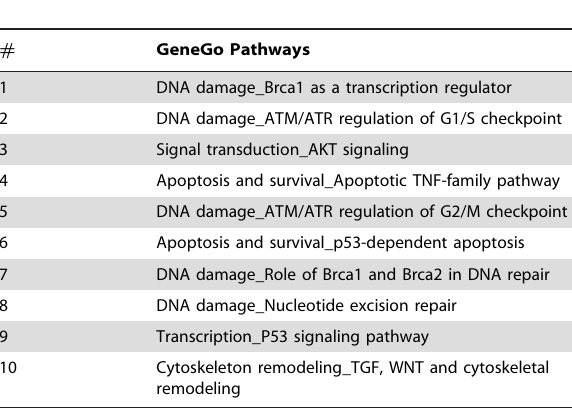
Table 4. The top ten GeneGo pathways generated by MetaCore when the 20 overlapping genes were